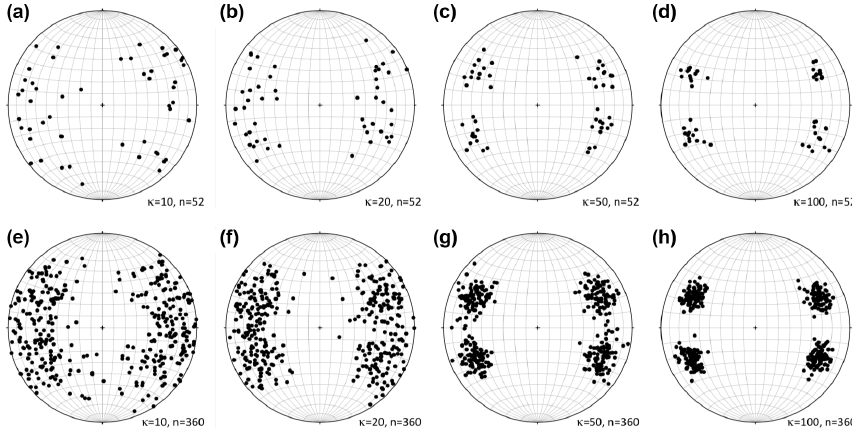
Figure 4. Stereographic projections (equal area, lower hemisphere) showing the eight synthetic datasets designed to model quadrimodal fault patterns in this study. (a–d) Synthetic fault datasets derived from equal mixtures of four Watson distributions with mean pole directions separated by an inter-fault dip angle of 60 ◦ and a strike separation of 52 ◦ . These models represent a “low fault count” scenario, with n = 52 and κ (the Watson dispersion parameter) varying from 10 to 100. (e–h) These models represent a “high fault count” scenario, with n = 360 and κ varying from 10 to